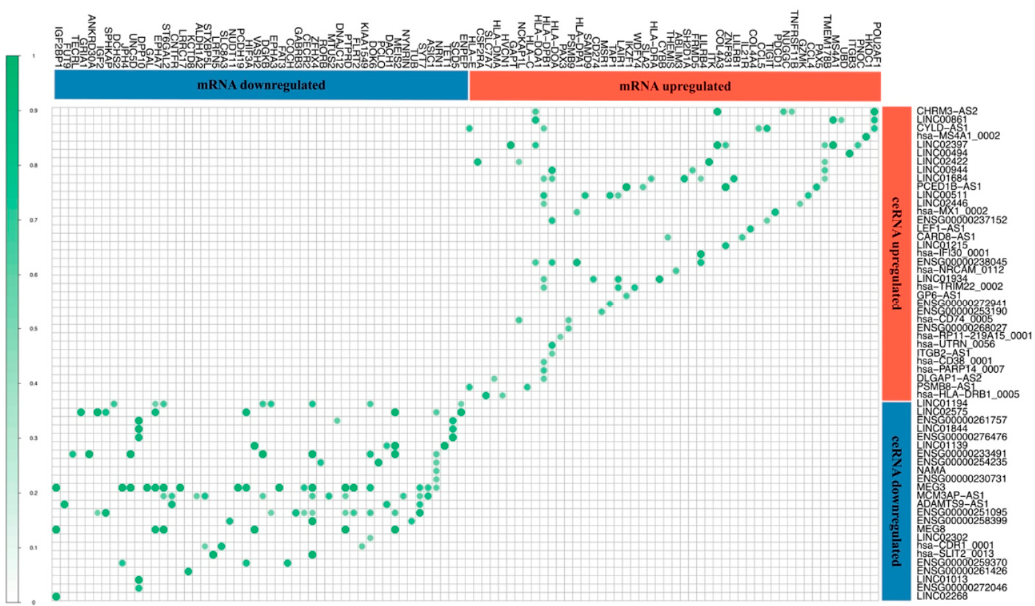
Figure 4. Correlation ceRNA network. Lineal correlation of expression of the differentially expressed ceRNAs and the differentially expressed mRNAs that belong to the ceRNA interaction network.